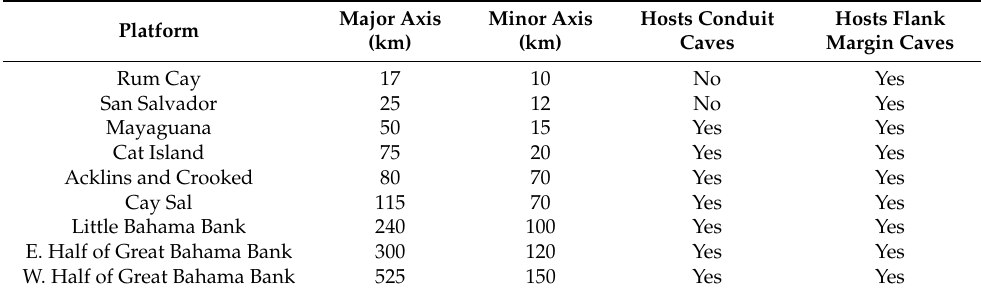
Table 1. The major banks in the Bahamian Archipelago along with their sizes and the presence of conduit caves as mapped through cave diving (data from Larson et al. [26]). All banks in the Bahamas support flank margin caves. Great Bahama Bank was divided at the Tongue of the Ocean to more accurately represent its